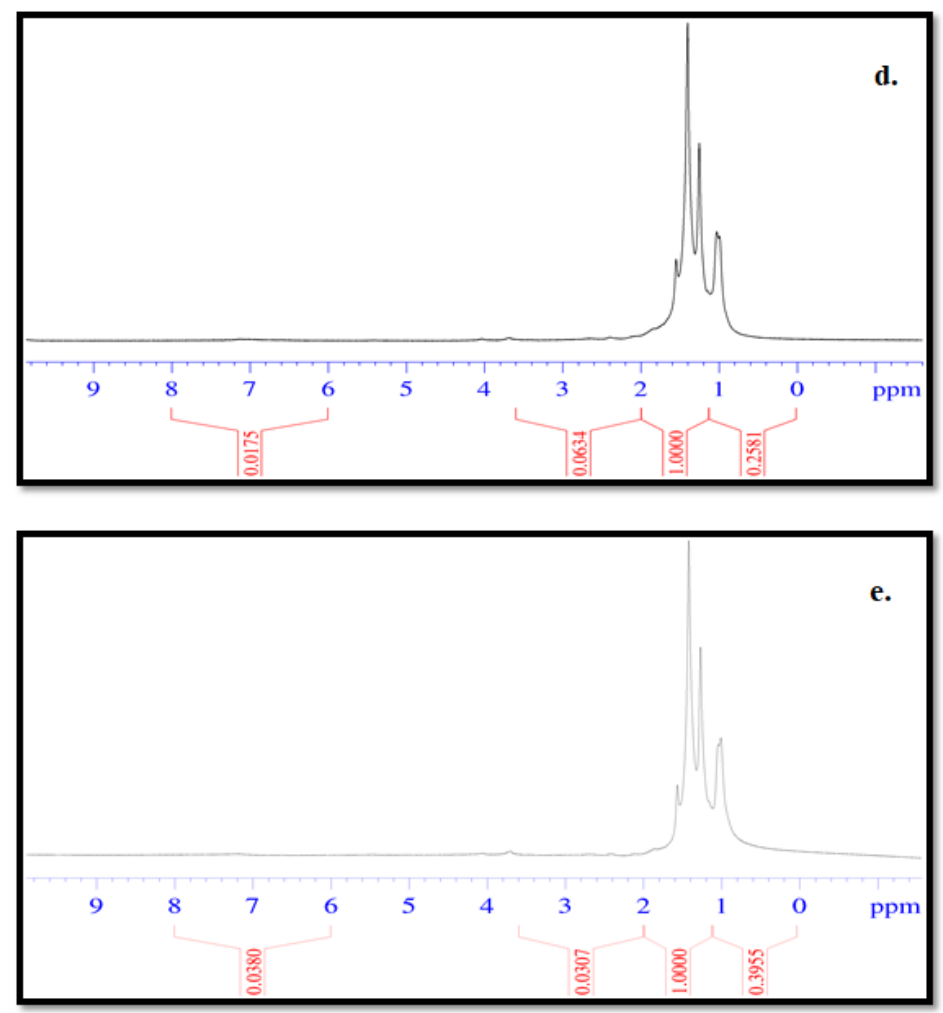
Figure 1. 1 H-NMR spectra of ( a ) Pen 50/70 ( b ) V2TQ, ( c ) V1, ( d ) V2D, ( e ) V2F.